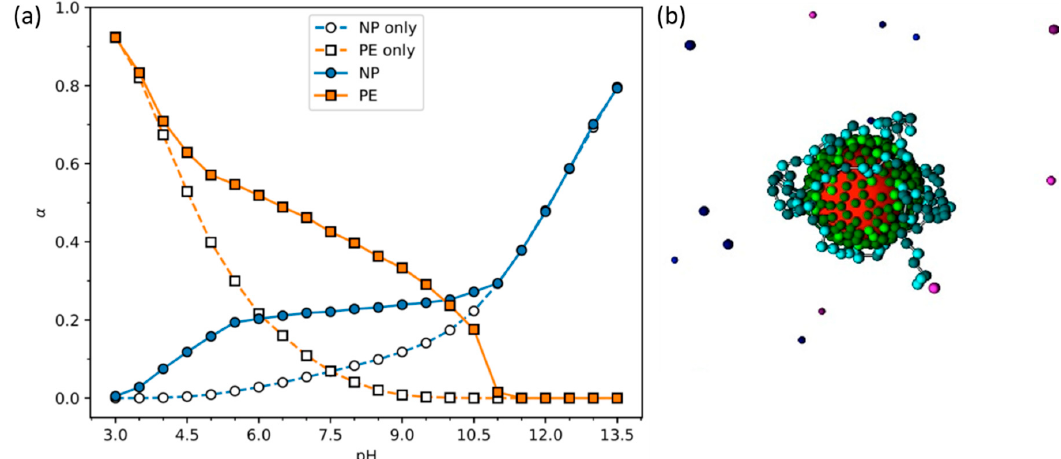
Figure 3. ( a ) Titration curves for a 120-monomer long polyelectrolyte (PE) (orange) and NP (blue) with pH sensitive groups both separately (dashed lines) and in a mixture (solid lines), given as the fractional charge ( α ) as a function of pH, obtained from Monte Carlo simulations. The difference between the dashed and solid lines shows that the fractional charge of the individual components increases in the presence of the oppositely charged NP or polymer. ( b ) Representative snapshot of adsorbed PE onto the NP. The PE is described as a sequence of hard-spheres (in green) connected by harmonic bonds. The NP is modeled as a hard-sphere with 20 Å with a density of 4.8 surface sites per nm 2 (in blue). Dark monomers and surface groups correspond to neutral groups, and particles with bright colors refer to charged groups. The pKa of the monomers and NP surface groups was set to 7.0 and 6.8, respectively. Purple and black particles are the counterions of the PE and NP, respectively. For